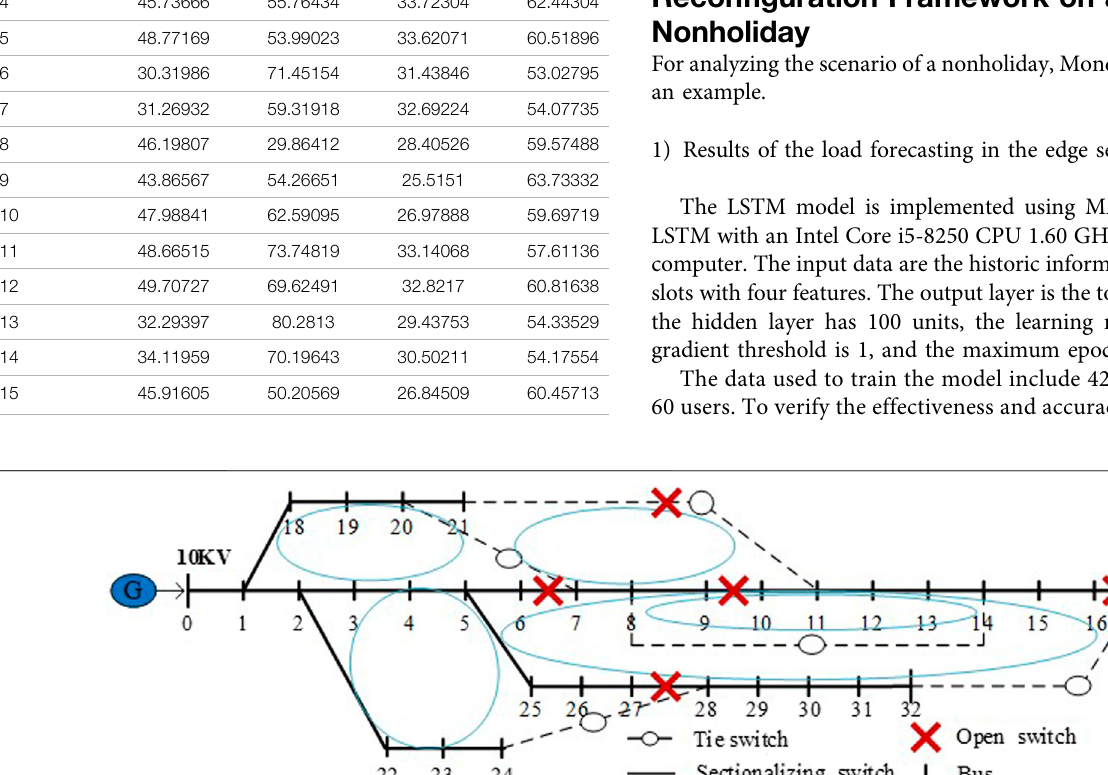
Frontiers in Energy Research |